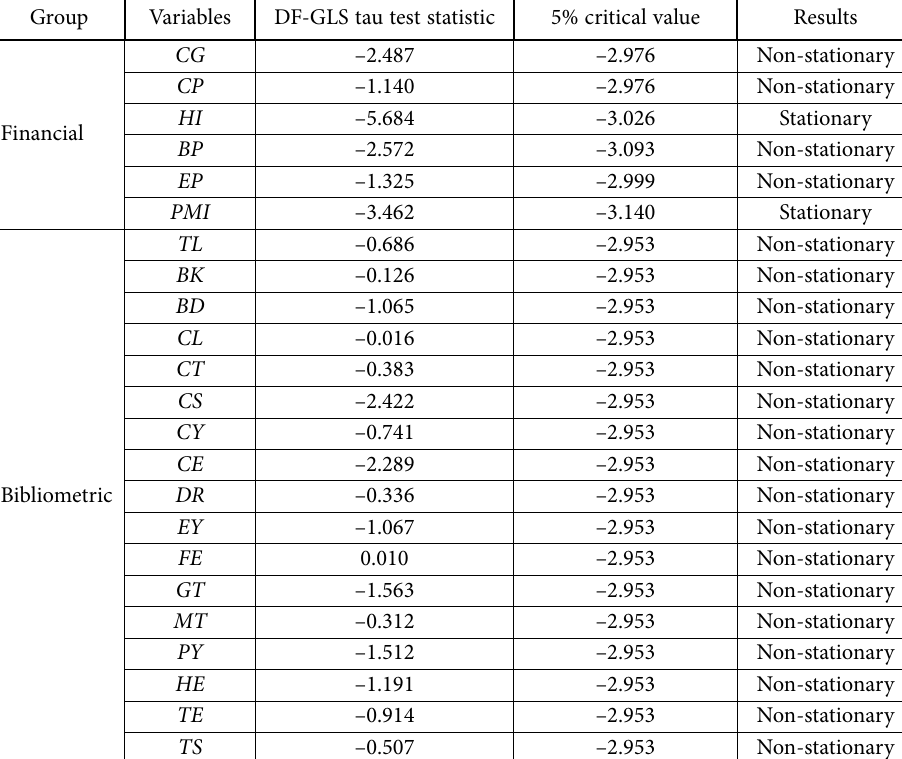
Table 3. Unit root results (source: authors’ calculation)